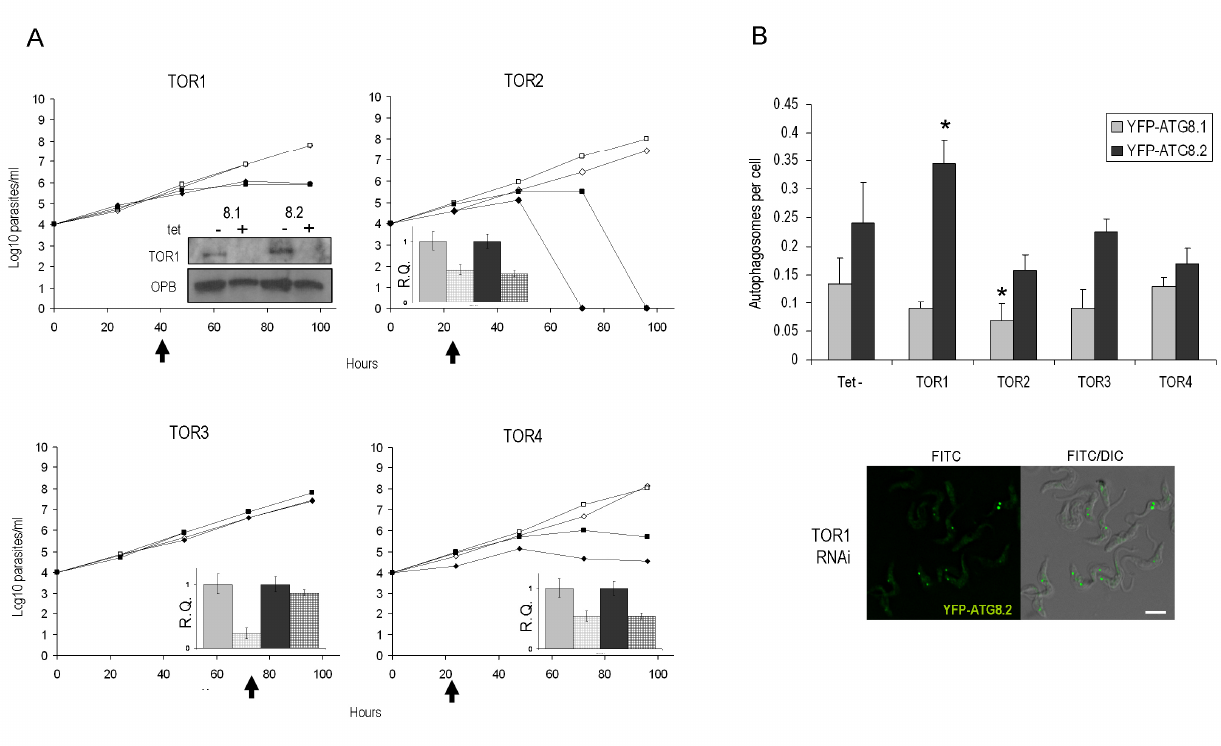
FIGURE 6: RNAi of TOR genes in bloodstream form. (A) Growth analysis of BSF RNAi mutants in vitro. RNAi of TOR genes in BSF 2T1 constitu- tively expressing YFP-ATG8.1 (diamonds) and YFP-ATG8.2 (squares). RNAi induced with tetracycline (filled symbols) and growth compared to controls (empty symbols) for 96 h. Cells were reseeded to 1 x 10 4 ml -1 at 48 h as required, with cumulative growth shown. Arrows indicate time point selected for microscopy analysis following. Inset: confirmation of RNAi specificity by western blot (where antibody available, TOR1 [22]) or by qPCR of TOR RNAi cell lines at selected analysis time points after tetracycline induction (hatch) or control in BSF 2T1 clones ex- pressing either YFP-ATG8.1 (grey) or YFP-ATG8.2 (black). Error bars represent one standard deviation derived from three replicates. (B) The mean number of autophagosomes per cell was determined in TOR RNAi lines by counting >200 cells at selected times after induction (arrows in A), with data displayed as a mean of at least three replicate experiments. Error bars represent standard deviation and asterisks indicate where data differed significantly from the mean of the un-induced controls *p<0.05. Constitutive expression of YFP-ATG8.2 in BSF 2T1 cells was visualised by fluorescent microscopy following individual RNAi of TOR1 . Left hand images FITC filter set, right hand images FITC DIC merge. Scale bar 5